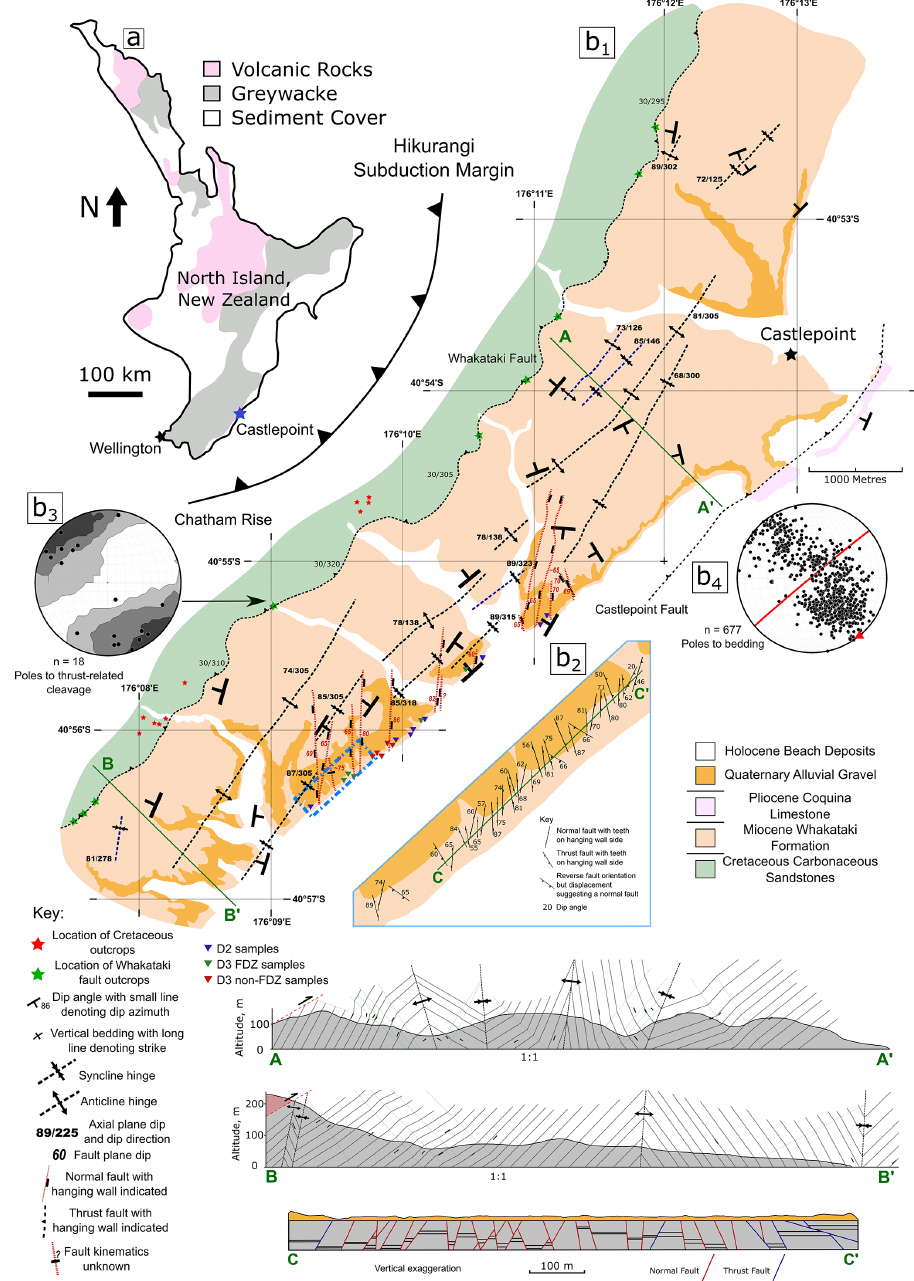
Figure 2. (a) Simplified geological map (Edbrooke, 2017) of New Zealand’s North Island, showing the study site location (red star) (co- ordinates: NZGD 2000, UTM Zone 60S, 5468211mN, 0430670mE). (b 1 ) Simplified geological map of the research area. The dominant structures at the field site are NE–SW trending folds and thrust faults with N–S trending normal faults along the coastline. Below are cross sections through the area. A–A (cid:48) and B–B (cid:48) highlight the asymmetrical fold geometry with synclines resembling box folds and anticlines resembling kink folds. The unconformable overlying Quaternary sediments have not been plotted to highlight the geometry of the folds. C–C (cid:48) is a schematic cross section drawn perpendicular to the average strike of normal faults. An arbitrary geological bed has been added to show possible displacements associated with faults. (b 2 ) A detailed map of the fault location and orientation along a ca. 1km stretch of coastline. Normal faults are dominant, with thrust faults found in areas of low normal-fault density. (b 3 ) Schmidt net with poles to cleavage planes observed in the damage zone of the Whakataki Fault, a large-scale thrust fault associated with the first phase of compression, D1. (b 4 ) Schmidt net of poles to bedding planes. The mean axial plane for all bedding is plotted as great circle (red line). Given that the axial plane trends parallel to the traces of the dominant thrust faults in the area, it is reasonable to assume, by assessing the poles to the axial planes, that the folding was induced by SE shortening. All Schmidt nets are plotted with the Stereonet 10 software of Allmendinger et al. (2011). https://doi.org/10.5194/se-12-141-2021 Solid Earth, 12, 141–170,